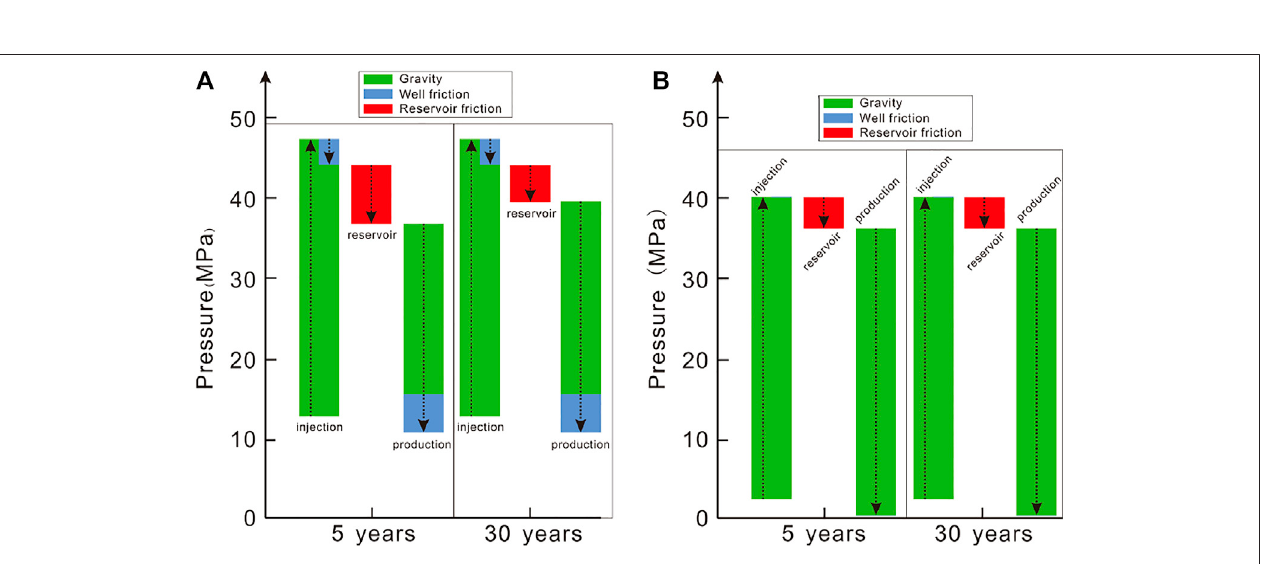
Frontiers in Earth Science |